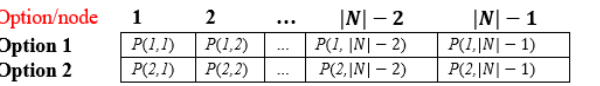
Figure 2. Probability matrix used by the PPBIL algorithm (Adapted from [1]).